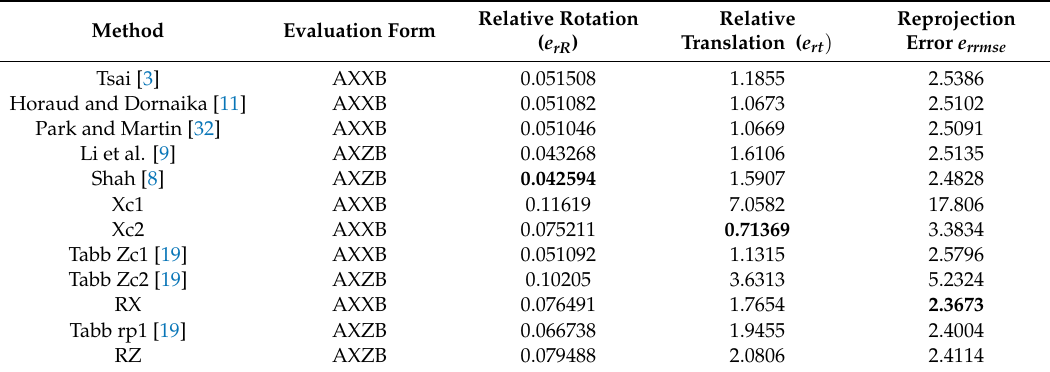
Table 2. Comparison of methods using the described error metrics for dataset 1.